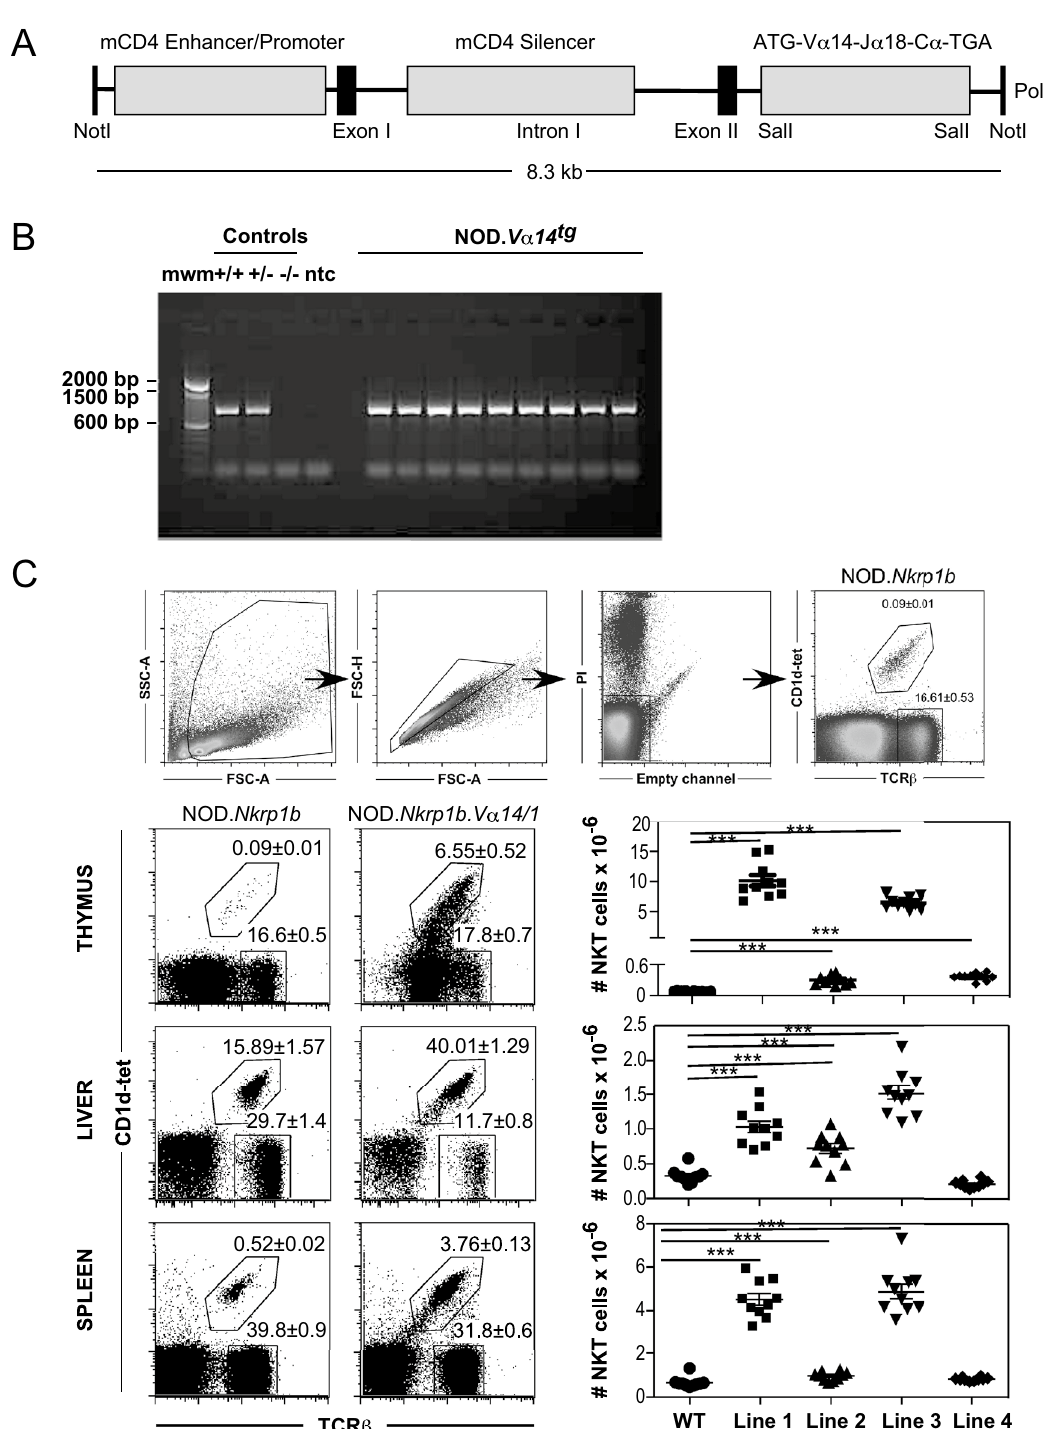
Figure 1. Production and characterisation of NOD. Va14 tg mice. ( A ) A diagram of the transgenic construct, which consists of a CD4 minigene, including a minimal CD4 promoter/enhancer and the CD4 intronic silencer 5’ of Vα14-Jα18 TCRα chain cDNA and a poly-A tail 17 . ( B ) Pups were genotyped by using construct-specific primers. mwm = molecular weight marker; ntc = no template control. Results are shown for nine individual transgenic mice from NOD. Va14 tg Line 1. ( C ) Thymic, hepatic and splenic NKT cell phenotyping of NOD. Va14 tg Lines 1–4 transgenic mice compared to WT NOD mice (n = 10: Data means (± SEM) from 5 males and 5 females for each group. Data are combined from two independent experiments and NKT gating is indicted at the top for WT NOD